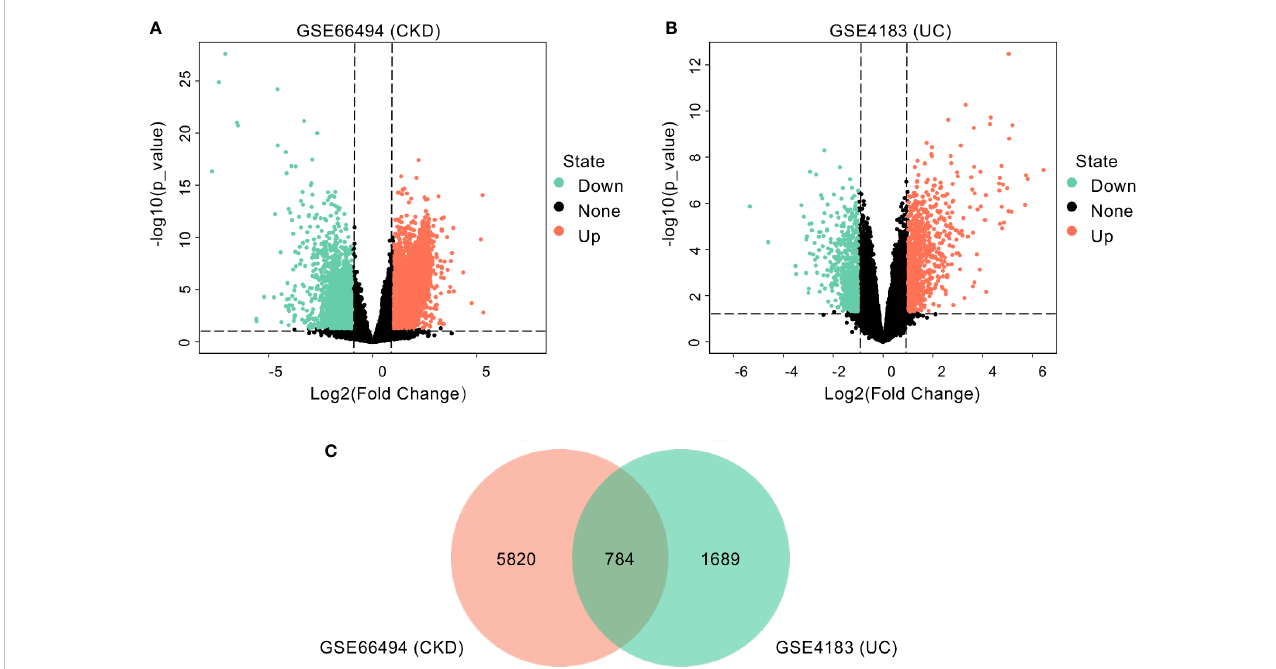
FIGURE 2 Identi fi cation of common DEGs. (A) Volcano plot revealed 6604 DEGs between CKD patients and healthy controls. (B) Volcano plot revealed 2473 DEGs between UC patients and healthy controls. (C) A total of 784 common DEGs were identi fi ed after taking the intersection of DEGs in CKD and UC. DEG, differentially expressed gene; CKD, chronic kidney disease; UC, ulcerative